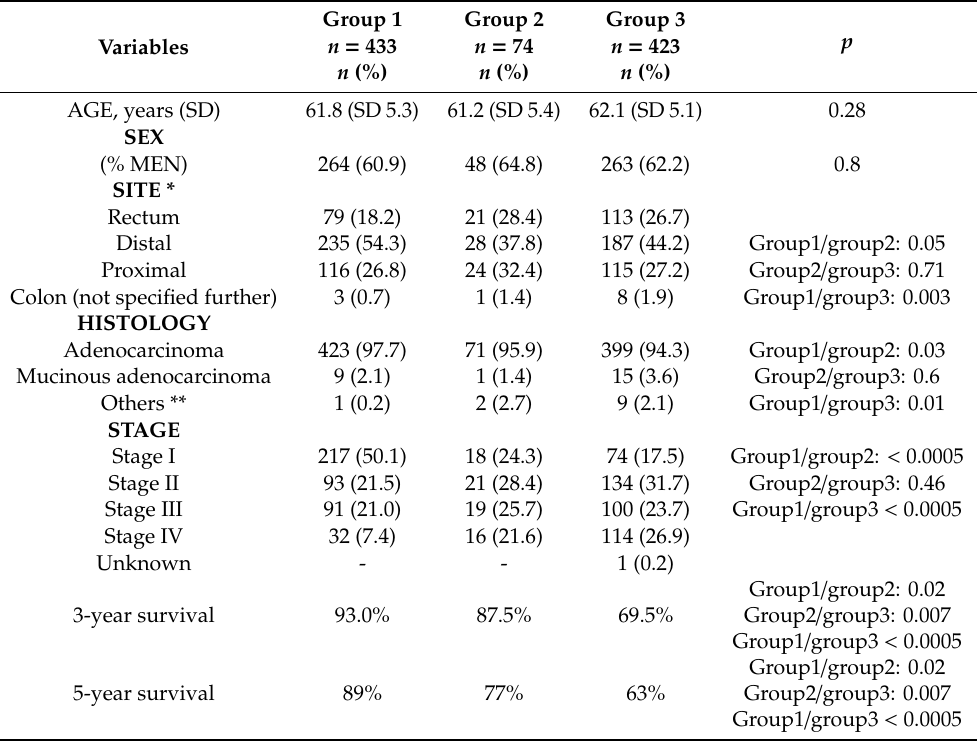
Table 2. Clinical characteristics of patients by